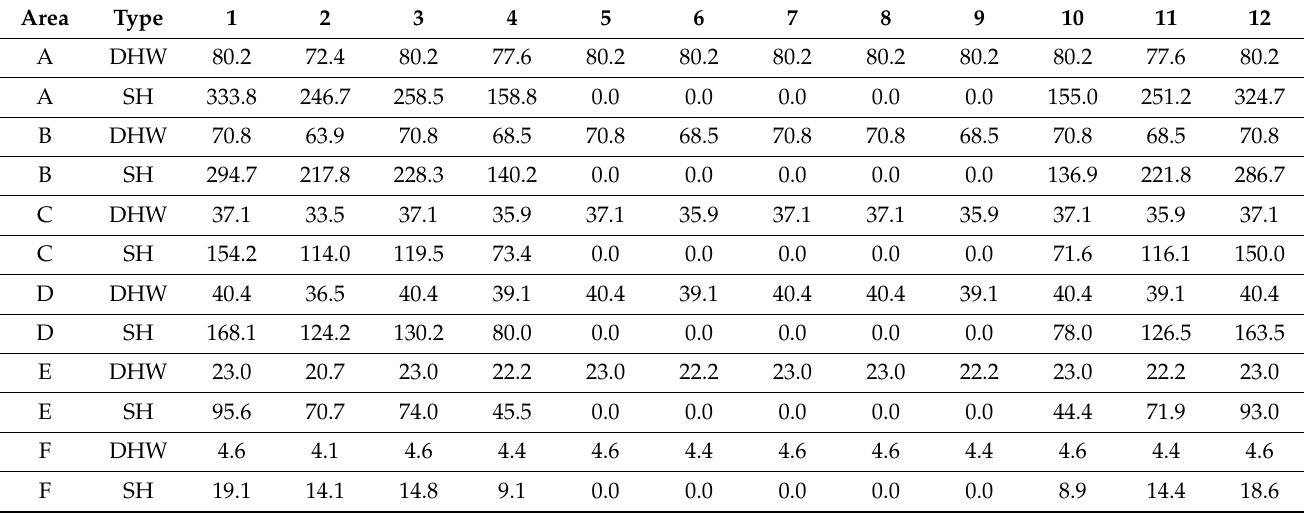
Table 7. Value of heat production in (TJ) in each